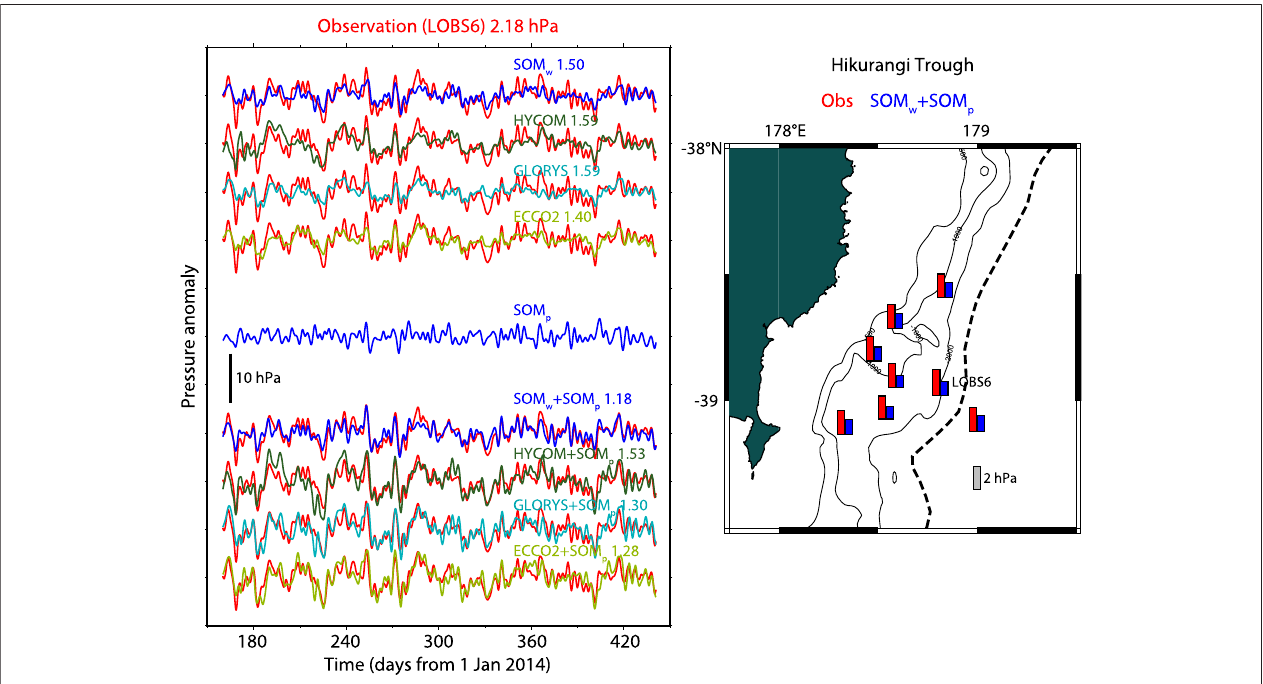
FIGURE6| Comparisonsbetweenobservedand modeled ocean bottom pressure atLOBS6 at theHikurangiTrough. Redindicates theobservation atthe period of 3 – 90 days. Blue, dark green, cyan, and light green indicate SOM, HYCOM, GLORYS, and ECCO2, respectively. Upper parts in left panel show comparisons to SOM forced by wind alone (SOM w ), HYCOM, GLORYS, and ECCO2. SOM forced by air pressure alone (SOM p ) (blue) is shown at the center. SOM p respectively added to SOM w , HYCOM, GLORYS, and ECCO2 are shown in the lower parts. Root-mean-square amplitude (in hPa) of the observed ocean bottom pressure is shown above the left panel. Root-mean-square amplitudes of residual (observed minus modeled) ocean bottom pressure are attached in the left panel for respective ocean models. Right panel shows the root-mean-square amplitudes of the observed and residual ocean bottom pressure with bar lengths. SOM w + SOM p is taken as the representative since this model contributed the best root-mean-square reduction between the models.